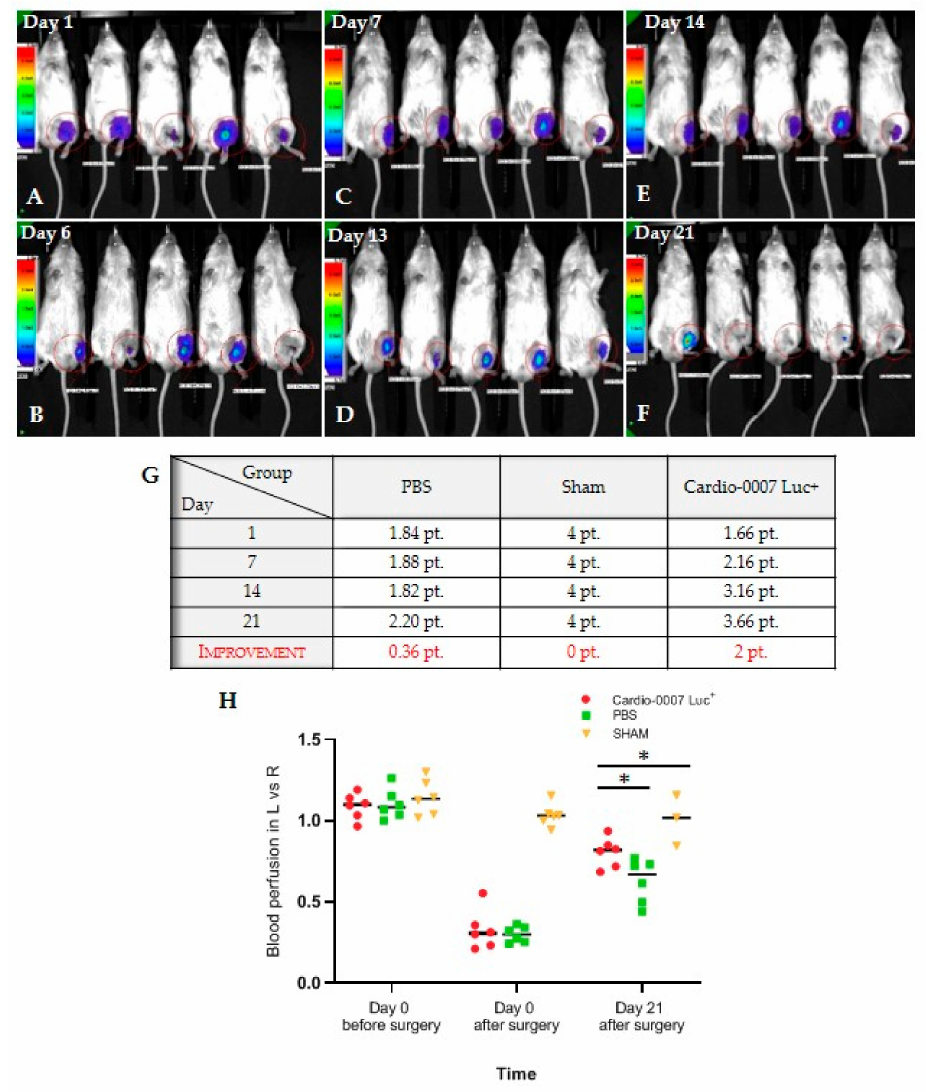
Figure 4. ( A – F) The evaluation of the lifespan of Cardio-0007 Luc + after administration in mice; ( G ) the results of macroscopic mice observations expressed at scale points: 0–1 pt.—pulled the hindlimb; 1.1–2 pt.—got the hindlimb stuck; 2.1–3 pt.—leaned on the hindlimb; 3.1–4 pt.—could go on hindlimb; ( H ) the results of blood perfusion measurements in the left, injured limbs (L) versus the right, healthy limbs (R). The data are in the form: mean ± SEM. * p ≤